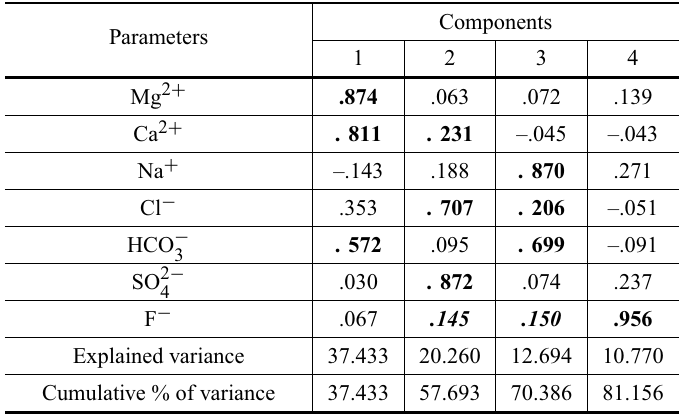
Rotated matrix with four components and characteristic parameters.